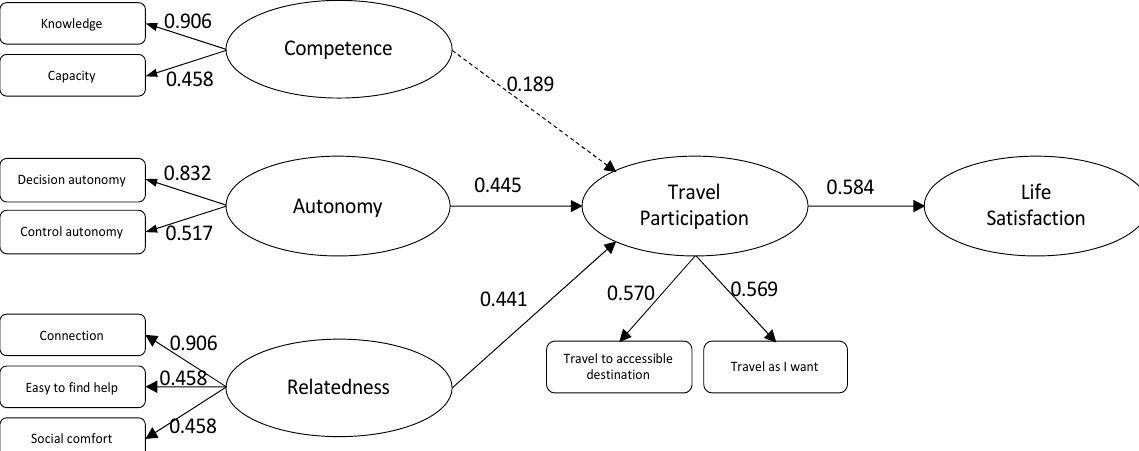
Figure 2. Self ‐ Determination Model of Participation in Travel ‐ Related Activities for PwSCI. Figure 2. Self-Determination Model of Participation in Travel-Related Activities for